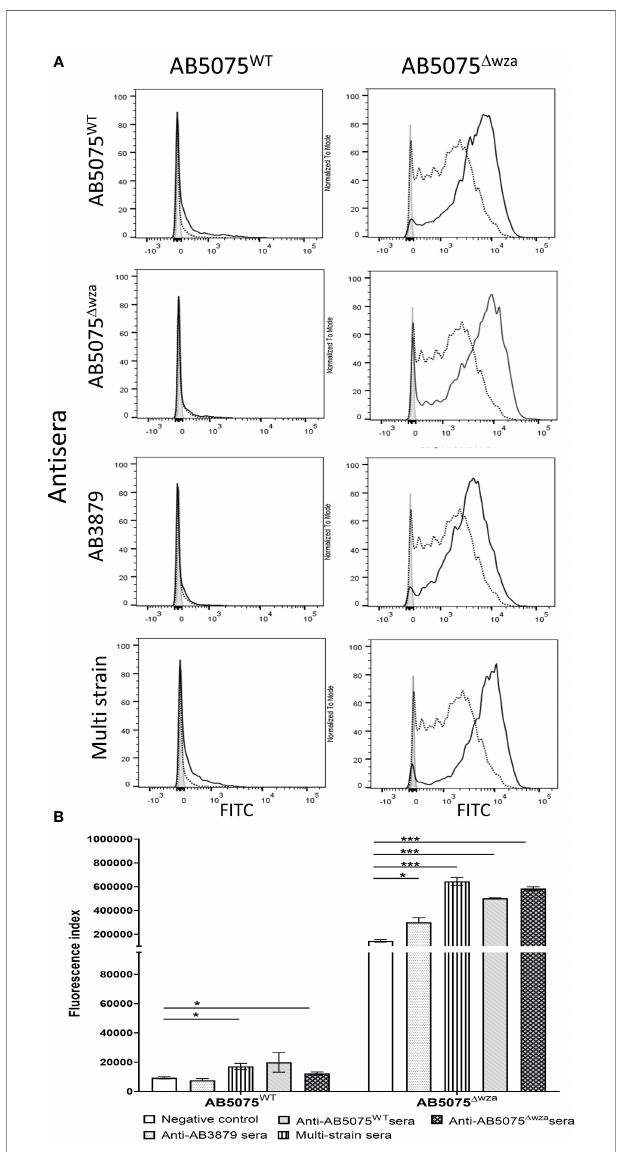
FIGURE 7 | Neutrophil opsonophagocytosis of wild type and un- encapsulated AB5075 isolates by mouse antisera. (A) FAMSE labelled AB5075 WT (left panel) and AB5075 D wza (right panel) were opsonized with either AB5075 WT , AB5075 D wza , AB3879 or multi strain antisera and incubated with healthy human neutrophils at Bacteria: Neutrophil MOI of 100:1. Sera from non-immunized mice was included as a control. Each graph shows a grey histogram that represents neutrophils incubated with no sera, black- dotted line represents neutrophils with bacteria opsonized with sera from non-immunized mice and black solid line represents neutrophils with bacteria opsonized with the respective sera indicated on the left. (B) Bar graph showing fl uorescence index calculated by multiplying the percentage of IgG positive bacteria to the median fl uorescent intensity of the positive population that was detected in each isolate, on the Y axis. The X-axis shows either AB5075 WT (left) or AB5075 D wza (right) opsonized with either AB3879, multi strain, AB5075 WT or AB5075 D wza antisera as indicated in the legend. Bars represent mean values for each condition/strain tested in triplicate and the error bars indicate standard deviations (SDs) (n=3). T-test was used for statistical analysis *p-value < 0.05, ***p-value < 0.001 Representative data from two independent experiments is